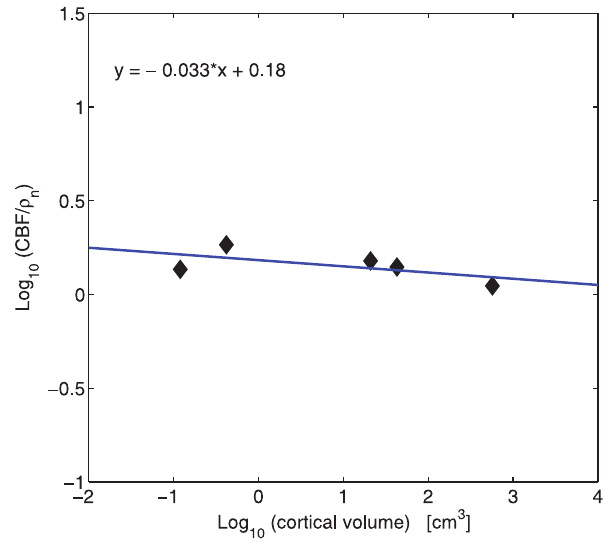
Figure 5. Invariance of cerebral blood flow per cortical neuron across mammals. The ratio of CBF to neuron density r n in the cerebral cortex does not correlate significantly with brain size (log-log plot yields y ~{ 0 : 033 x z 0 : 183 , R 2 ~ 0 : 39 , p ~ 0 : 261 ). The value of CBF for each species is the arithmetic mean of regional CBF across cerebral cortex.